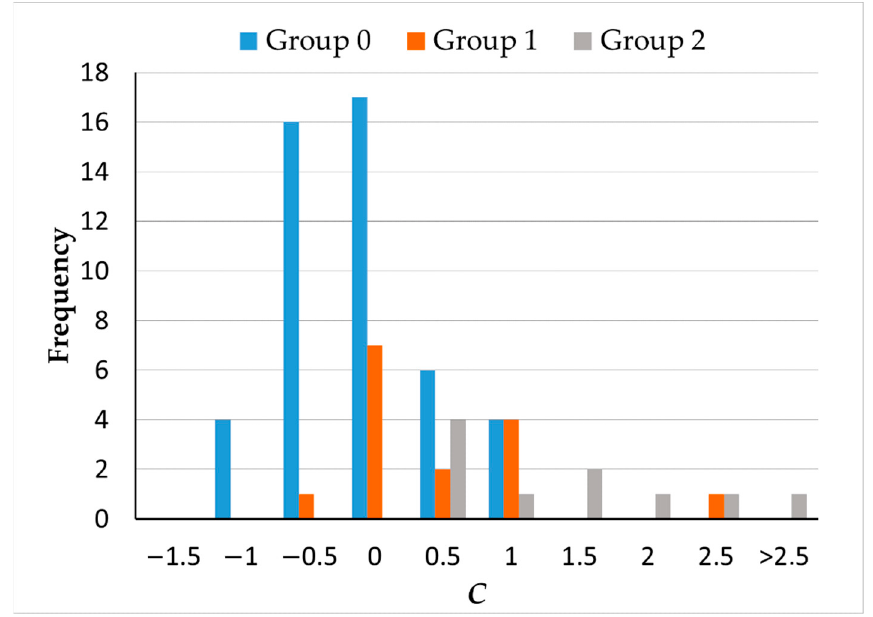
Figure 6. Distributions of principal component C for three groups: 0 = controls (blue), 1 = moderated smokers (orange), and 2 = severe smokers (grey).